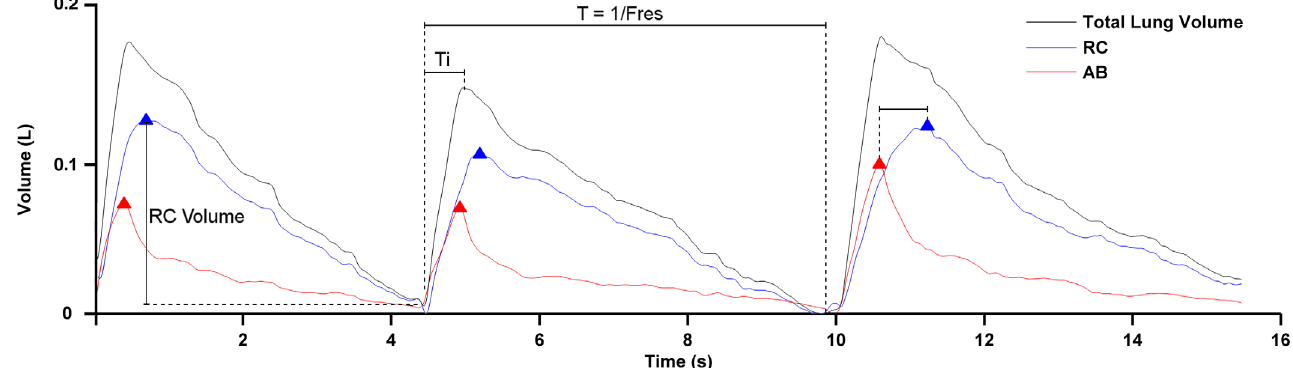
Fig 1. Illustration of rib cage (RC), abdominal (AB) and total lung volumes during three breath cycles of a classical singer performing a singing task (task 1: Waltzing Matilda). Parameters assessed from respiratory waveforms are indicated: respiratory frequency (Fres), time of inspiration (Ti), RC volume and time shift between peak volume of RC and